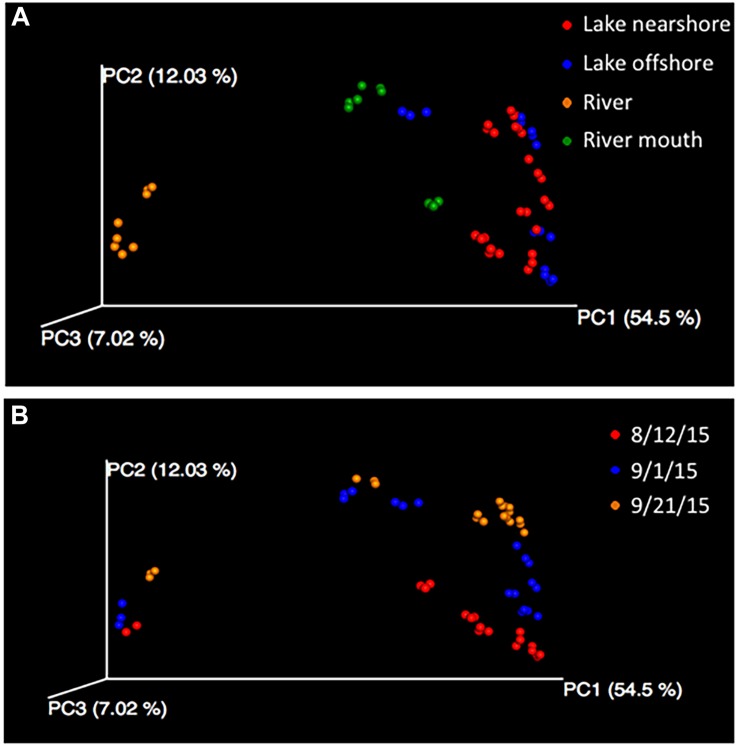
Principal coordinate analysis (PCoA) of Bray Curtis dissimilarity metrics of samples labeled according to the (A) water sources and by (B) sampling date. Differences among microbial communities are significant, PERMANOVA and ANOSIM P = 0.001 and meets the assumption of dispersion homogeneity because PERMDISP is not significant.